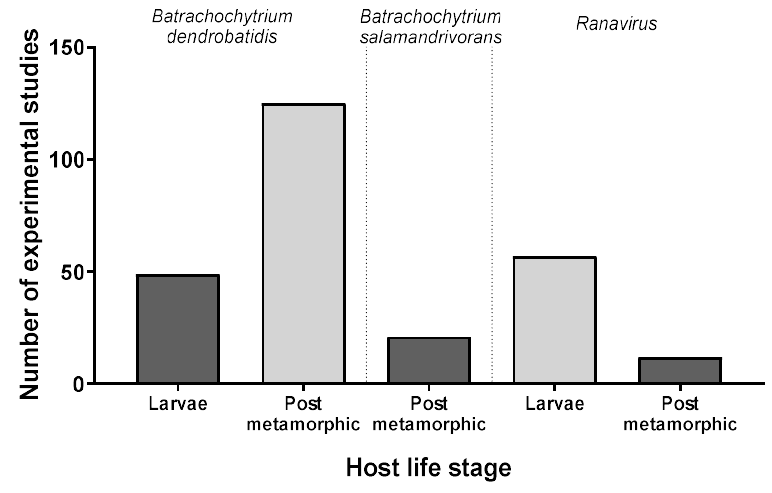
Figure 4. The number of experimental studies conducted at a single life stage. Obtained from direct counts from Table 1.